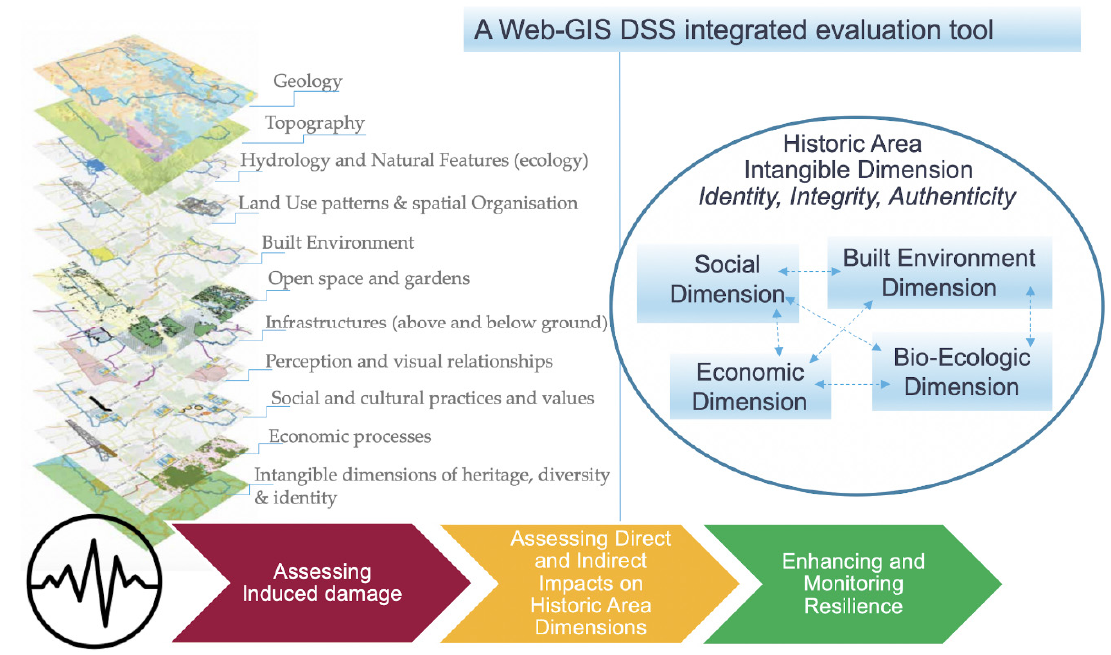
Figure 1. ARCH DSS integrated evaluation tool to support the assessment of earthquake-induced damage and impacts on HAs’ functions for monitoring resilience.